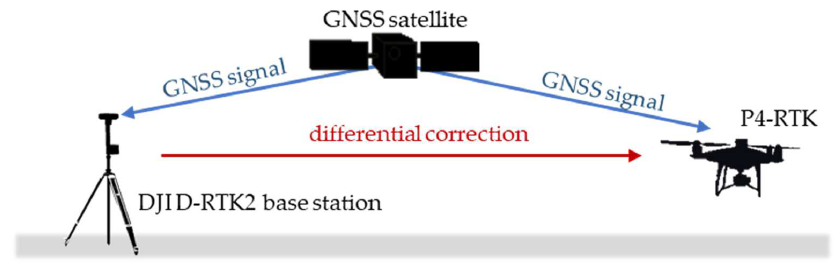
Figure 12. Operating principle of D-RTK2 base station correction.